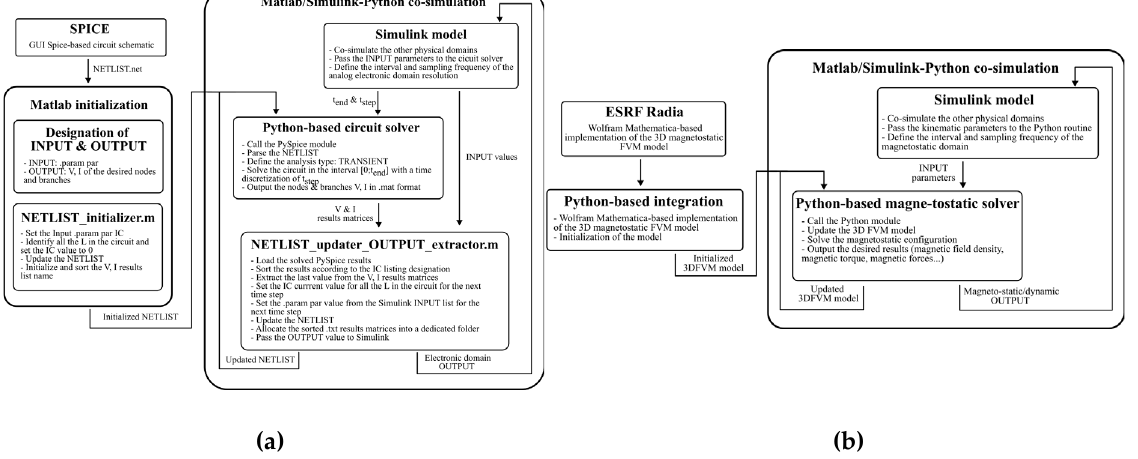
Figure 3. ( a ) PySpice–MATLAB/Simulink co-simulation logic; ( b ) ESRF Radia–MATLAB/Simulink co-simulation logic.